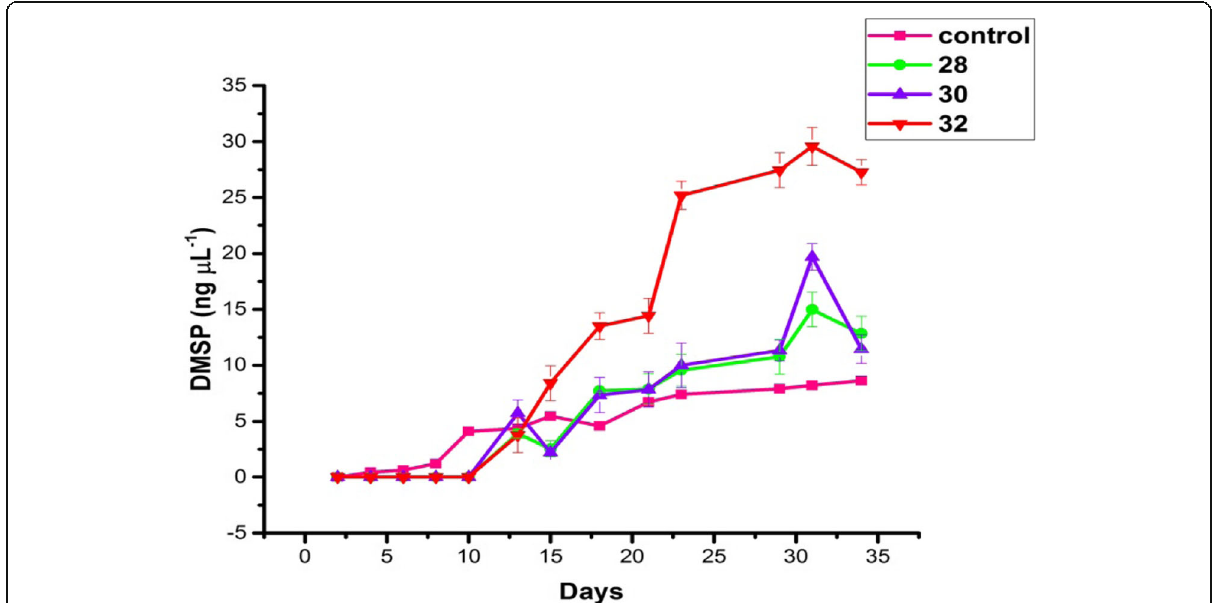
Fig. 3 Effect of salinity (PSU) on DMSP concentration in batch cultures of P.